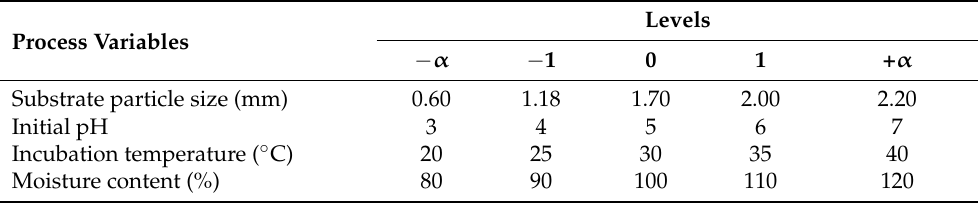
Table 1. Process variables and its levels used in